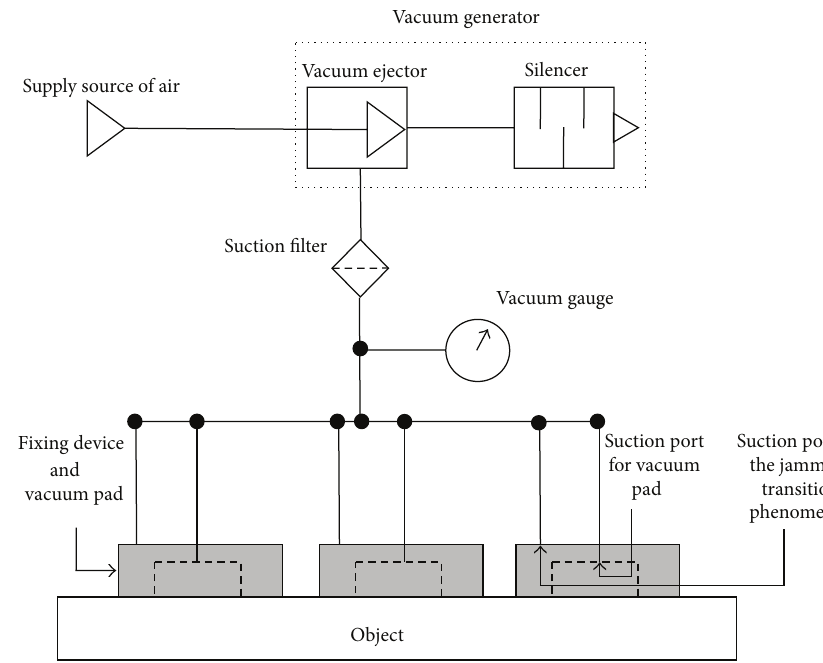
Figure 10: Vacuum circuit of the proposed holding device.